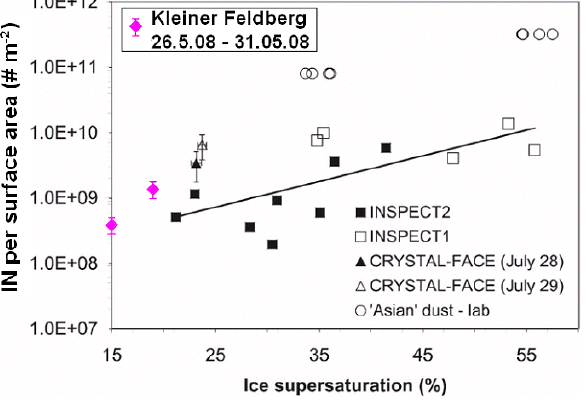
Fig. 9. Number of active ice nuclei per surface area of dust particles as function of supersaturation with respect to ice. Figure taken from Phillips et al. (2008), with data from this work (pink diamonds) added.